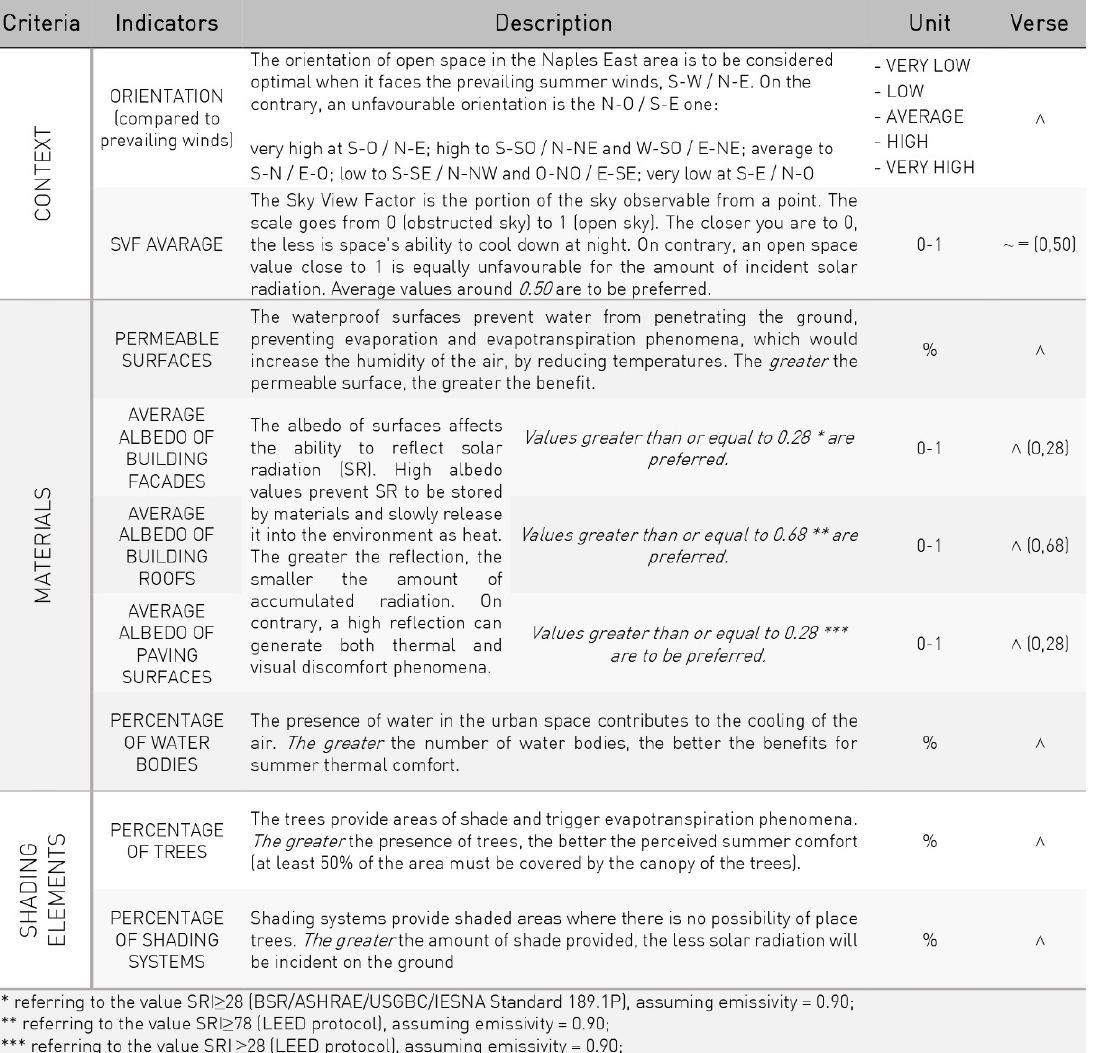
Figure 7. Example of a matrix of technological and morphological knowledge of the sample areas of urban pattern clusters.